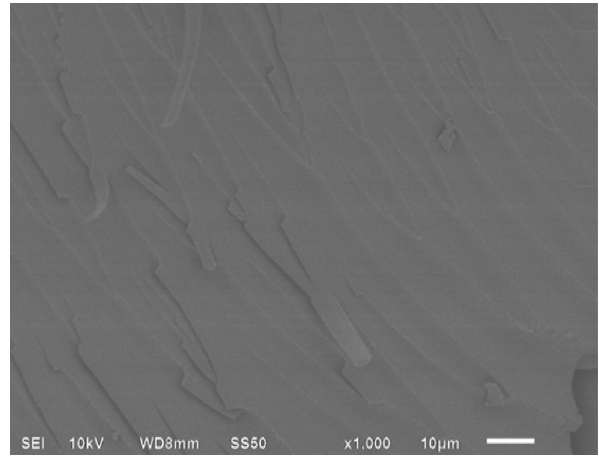
Figure 5: Scanning electron micrograph for (CY-230 +